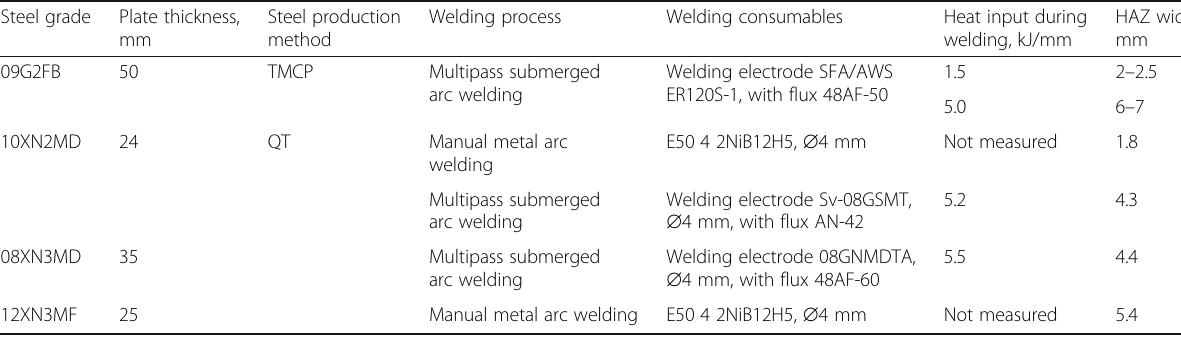
Table 3 Steel thickness, production method, and welding parameters Steel grade Plate thickness,